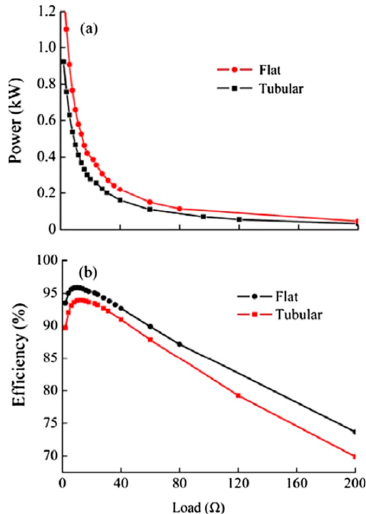
Figure 12. Specific power ( a ) and efficiency ( b ) vs. external load [36].